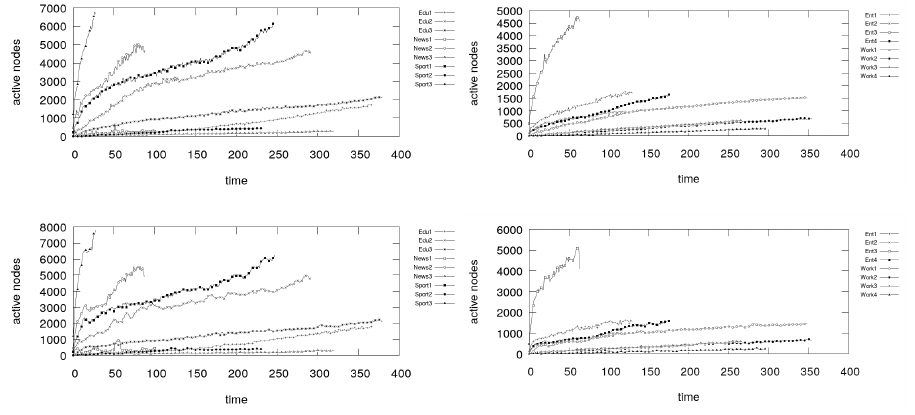
Figure 17. Number of active nodes detected by